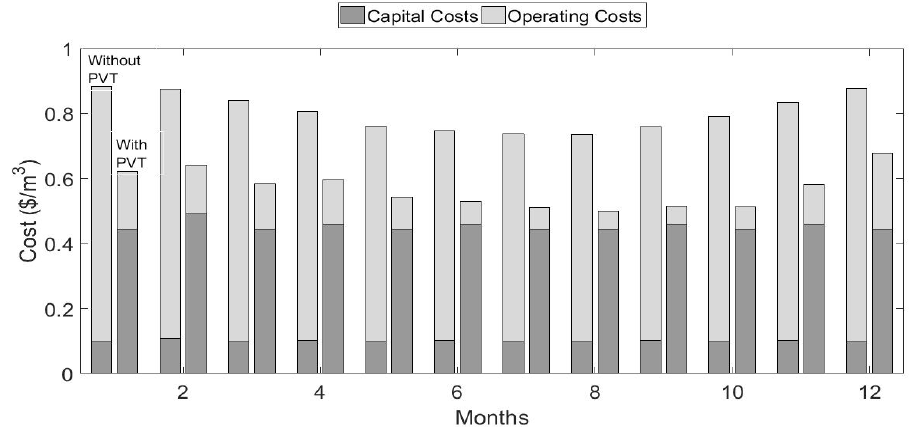
Figure 13. Monthly average cost/cubic meter of production, for a plant that has no PVT versus a plant with optimized PVT.